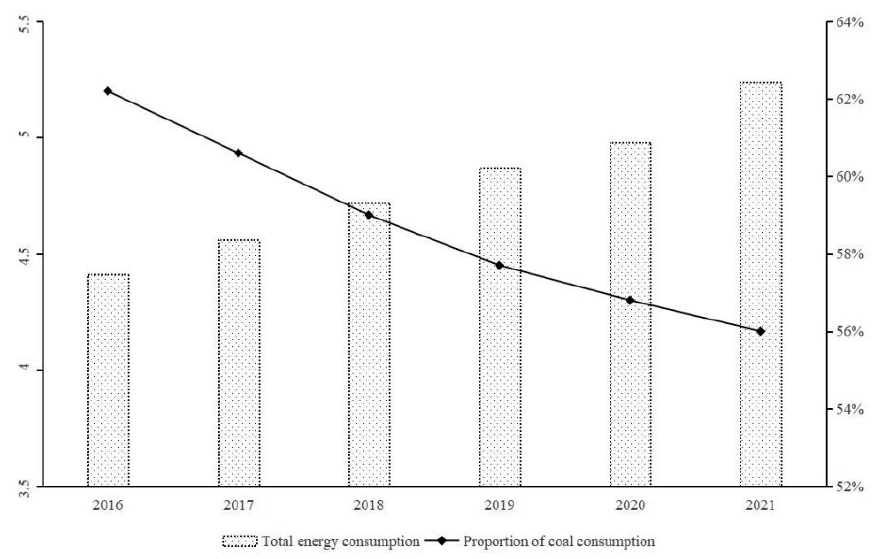
Figure 1. The trend of China’s energy consumption.